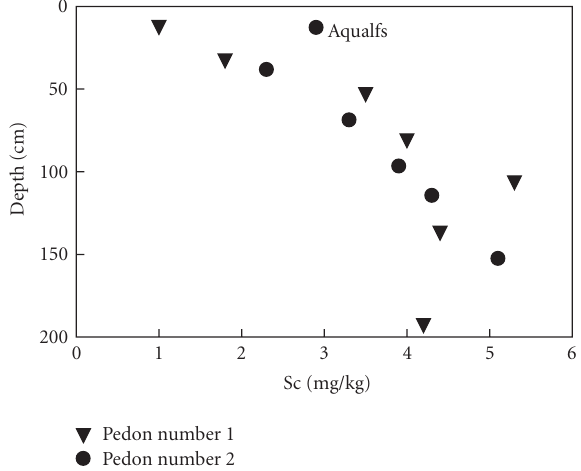
Figure 3: Soil profile Sc depth distribution for the Aqualf